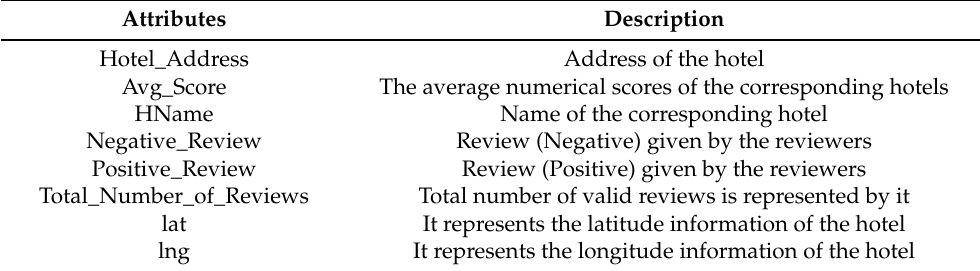
Table 4. Description of the attributes which we considered from the Booking Dataset.